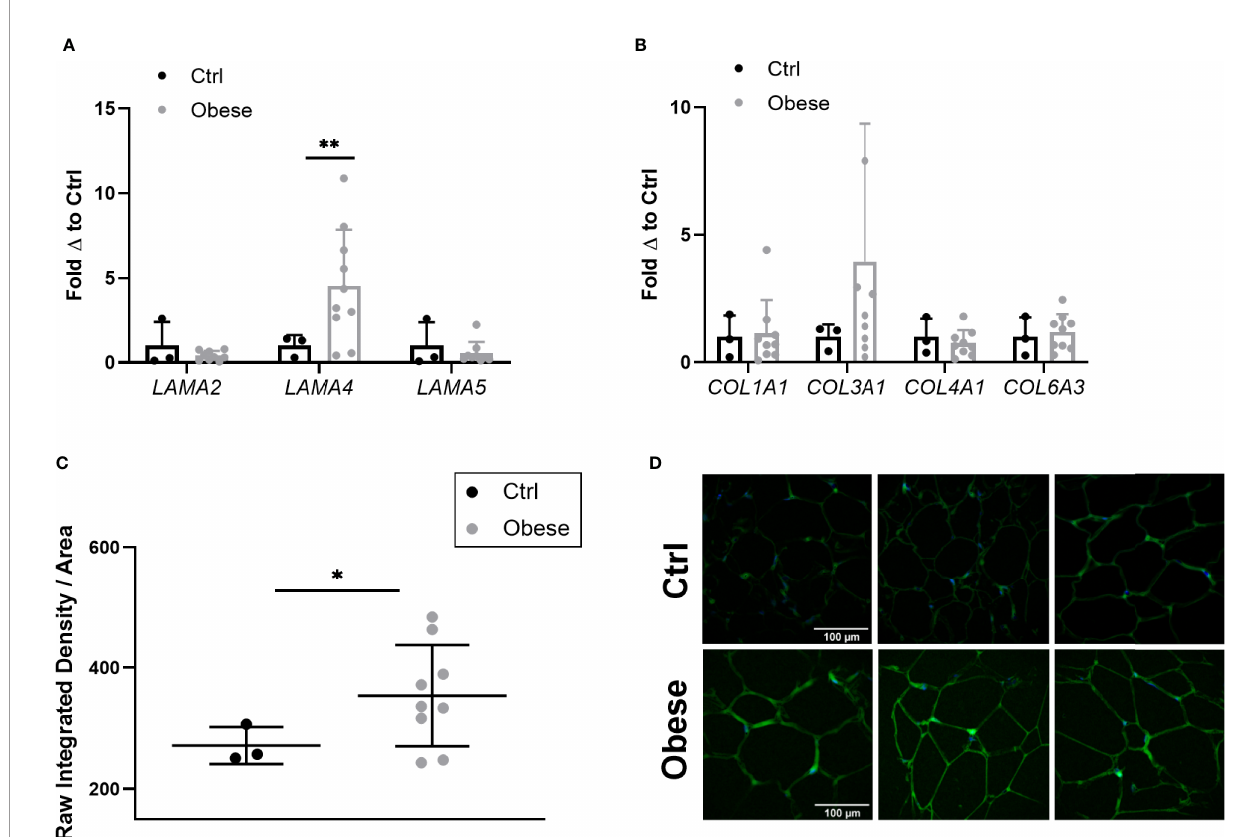
FIGURE 4 | Expression of laminin- a chains and collagen species in sWAT of human subjects. (A) Laminin- a chain mRNA expression in sWAT biopsies of female control (BMI<30) and obese (BMI>35) subjects normalized to average of control subjects. Control (n=3), Obese ( LAMA2 , LAMA5 n=9, LAMA4 n=10). (*,**) indicates p < 0.05, 0.01, respectively. Data are Means ± SD. (B) Collagen species mRNA expression in sWAT biopsies of human subjects normalized to average of control subjects. Control (n=3), Obese (n=9). (C) Density of extracellular LAMA4 as determined by raw integrated density signal over total area of signal in fi xed sections of sWAT from control and obese subjects. Control (n=3), Obese (n=9). (D) Representative images of extracellular LAMA4 immuno fl uorescence staining from control and obese sWAT. LAMA4 (in green) and DAPI (in blue). All images are 40X magni fi